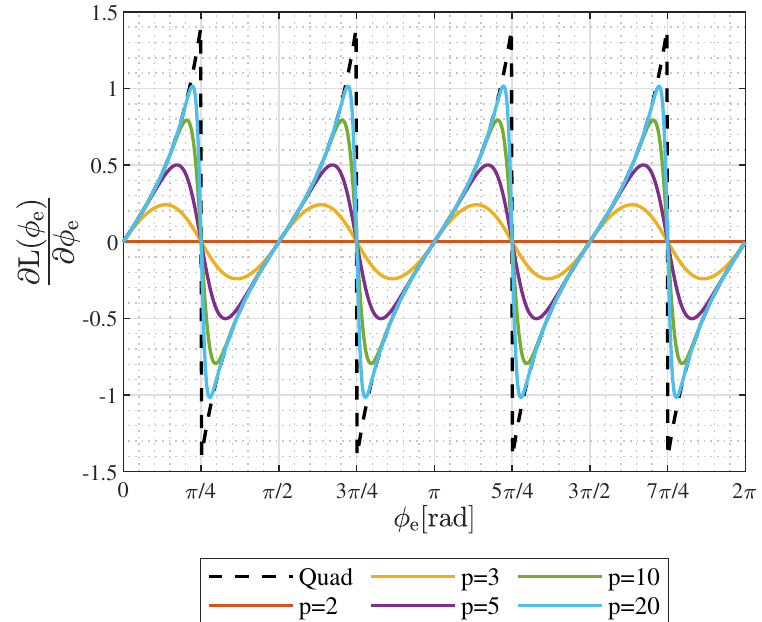
Figure 5. Derivative of phasor length for different values of p .